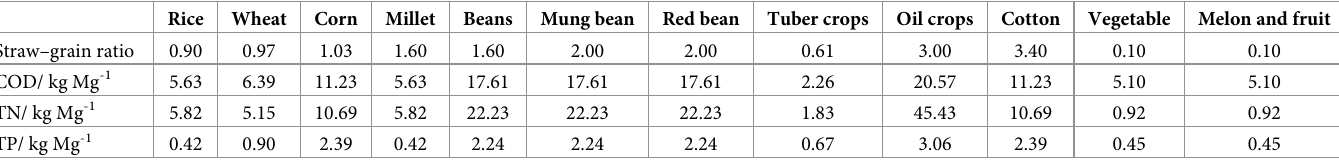
Table 2. Straw–grain ratios and pollutant production coefficients of straws from different